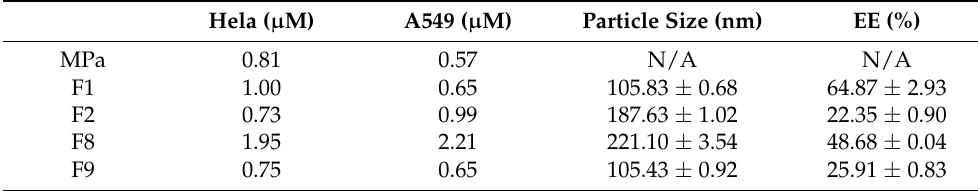
Table 5. IC 50 ( µ M) values against HeLa or A549 cells, particle size, and entrapment efficiency (EE) of free MPa solution, F1, F2, F8, and F9.